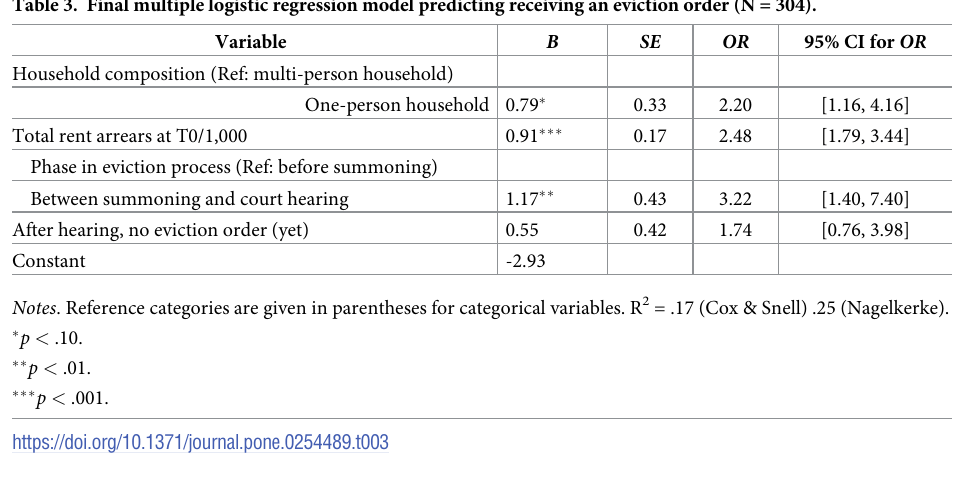
The level of rent arrears at T0 proved to be a strong predictor for eviction orders: the odds of receiving an eviction order were more than two times greater when rent arrears were increased by € 1,000 ( OR = 2.48; 95% CI = 1.79, 3.44). Furthermore, the odds of receiving an eviction order were more than two times greater for single tenants compared to households of